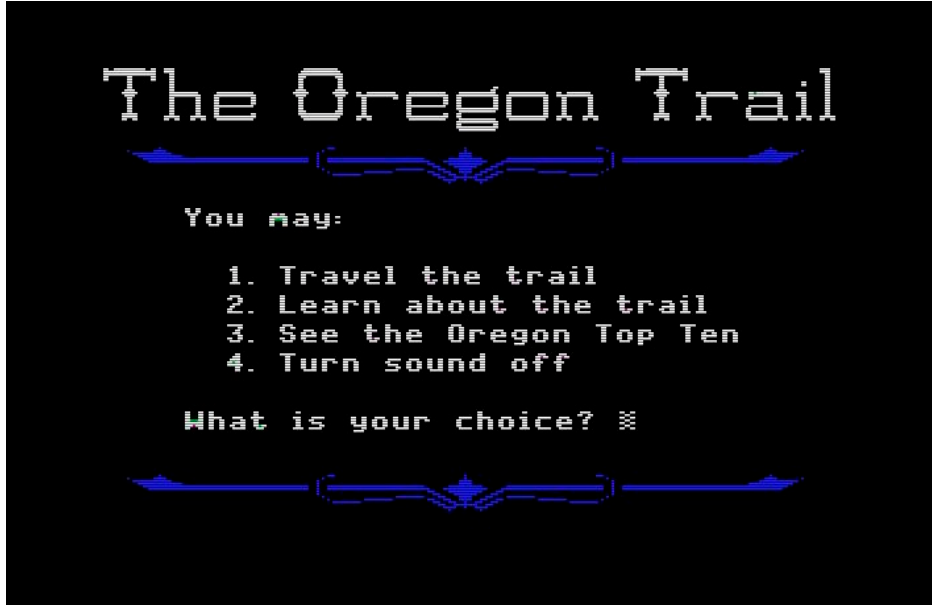
Figure 1. This screen capture from The Oregon Trail shows the game’s simple interface.